Question: In one sentence, what is this figure communicating?
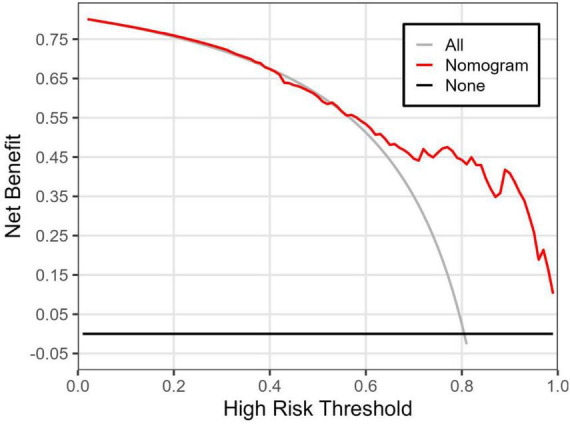
Answer: Decision curve analysis (DCA) of the frailty stratification model.